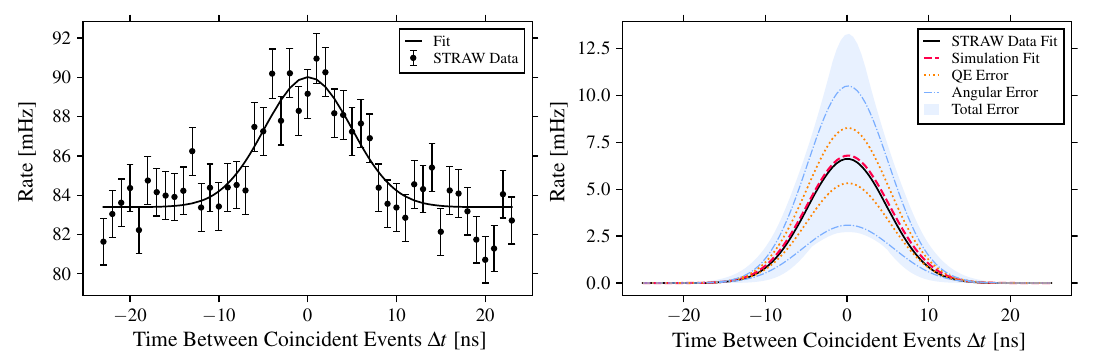
Fig. 9 Left: STRAW coincidence histogram with Gaussian fit. Right: Gaussian fits to coincident detection rate distributions of STRAW data withthebaselinesubtracted(black)andsimulation(red)plottedwiththe total systematic error band (blue). The dotted and dashed-dotted lines